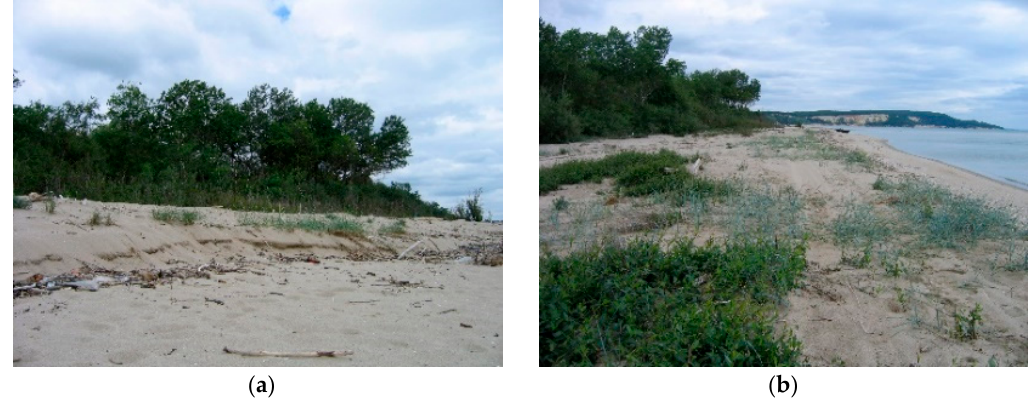
Figure 1. Communities of Leymus racemosus subsp. sabulosus , Ammophila arenaria , and Thinopyrum ponticum (former protected area Kamchiyski Pyasatsi, 43°00 ′ 48.20 ′′ N, 27°53 ′ 28.12 ′′ E): ( a ) Considerable damages after the storm in March 2015; ( b ) recovered plant communities of dominant sand stabilizers after one vegetation season.